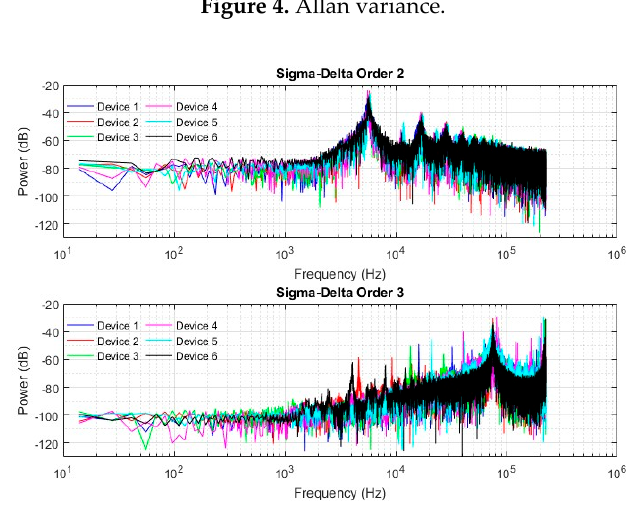
Figure 4. Allan variance.